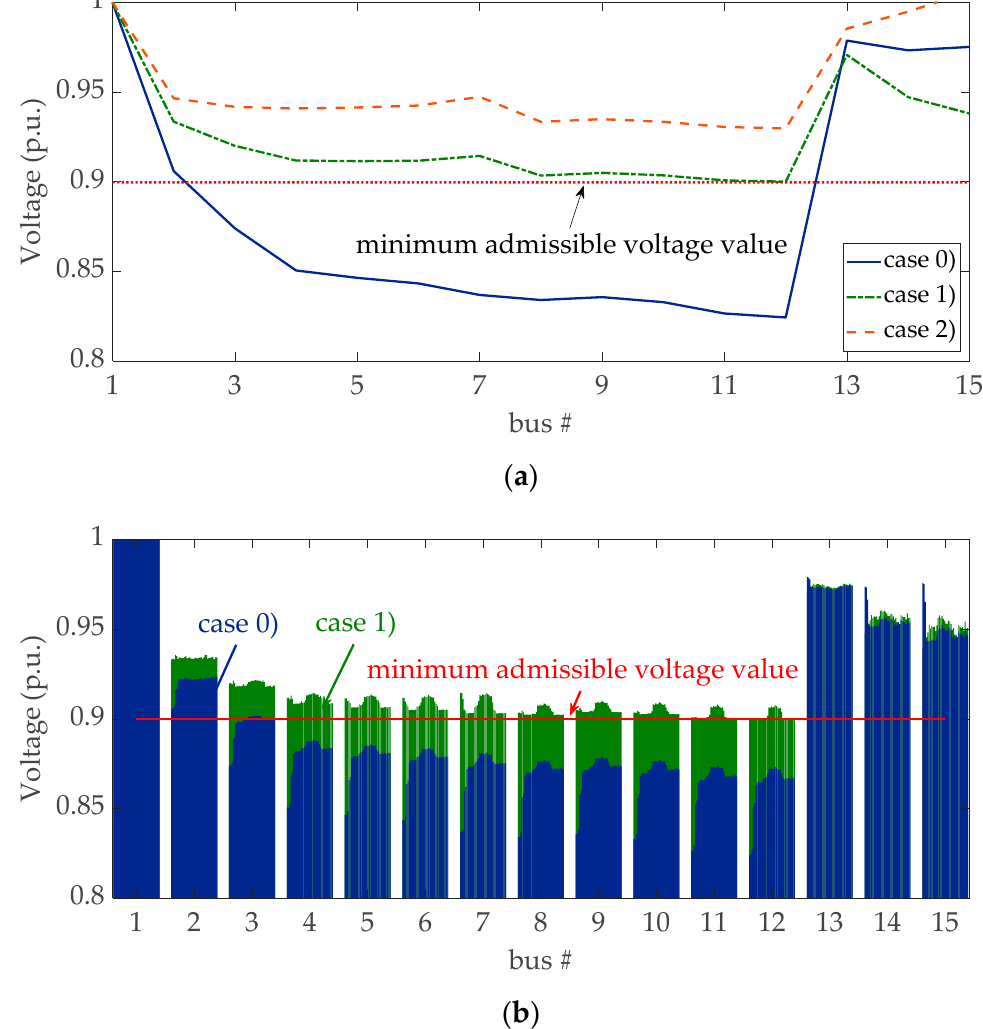
Figure 8. Voltage profile corresponding to the three case studies (hour 11:02) ( a ); bus voltage values at all time intervals corresponding to case (0) and case (1) ( b